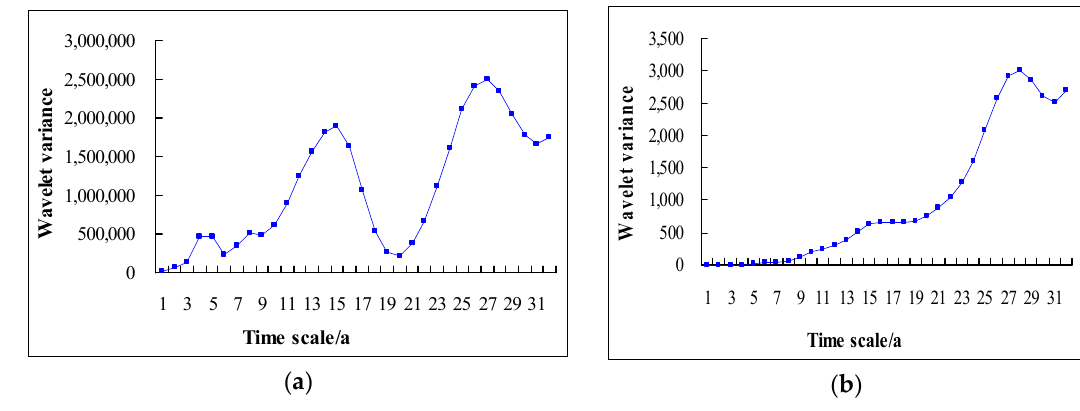
Figure 7. Wavelet variance plot. ( a ) for atmospheric precipitation; ( b ) for spring water level.